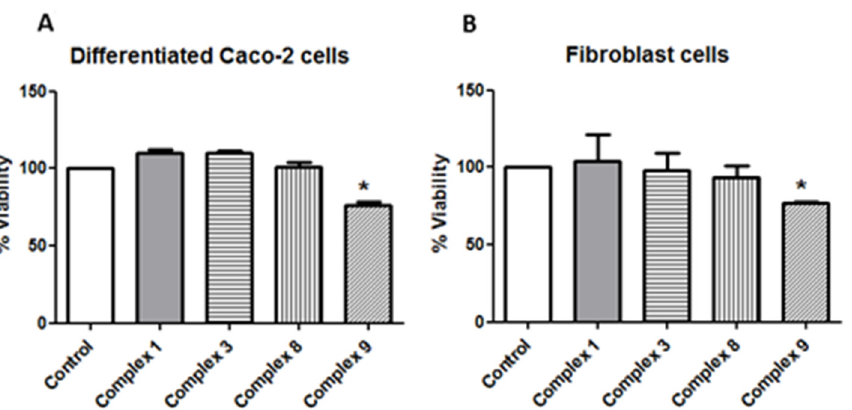
Figure 1. ( A ) Viability percentages obtained after the treatment of differentiated Caco-2 cells with